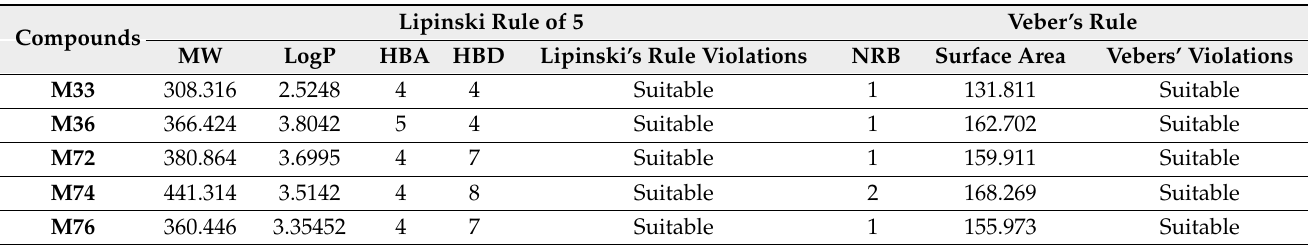
Table 2. Predicted properties under Lipinski’s rule of five and Veber’s rule of selected